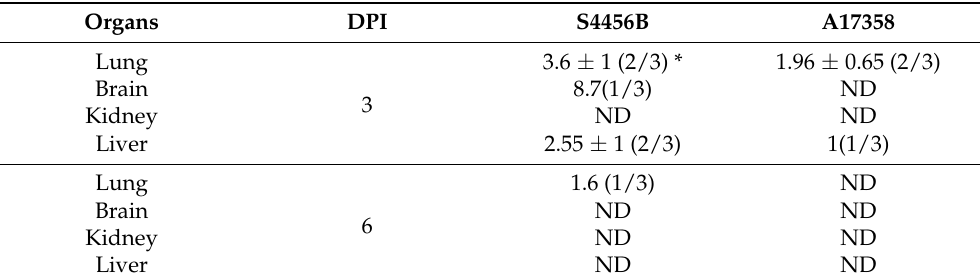
Table 2. Viral loads (Log 10 RNA copy number) of H9N2 viruses in different organs of infected mice with a dose of 10 7